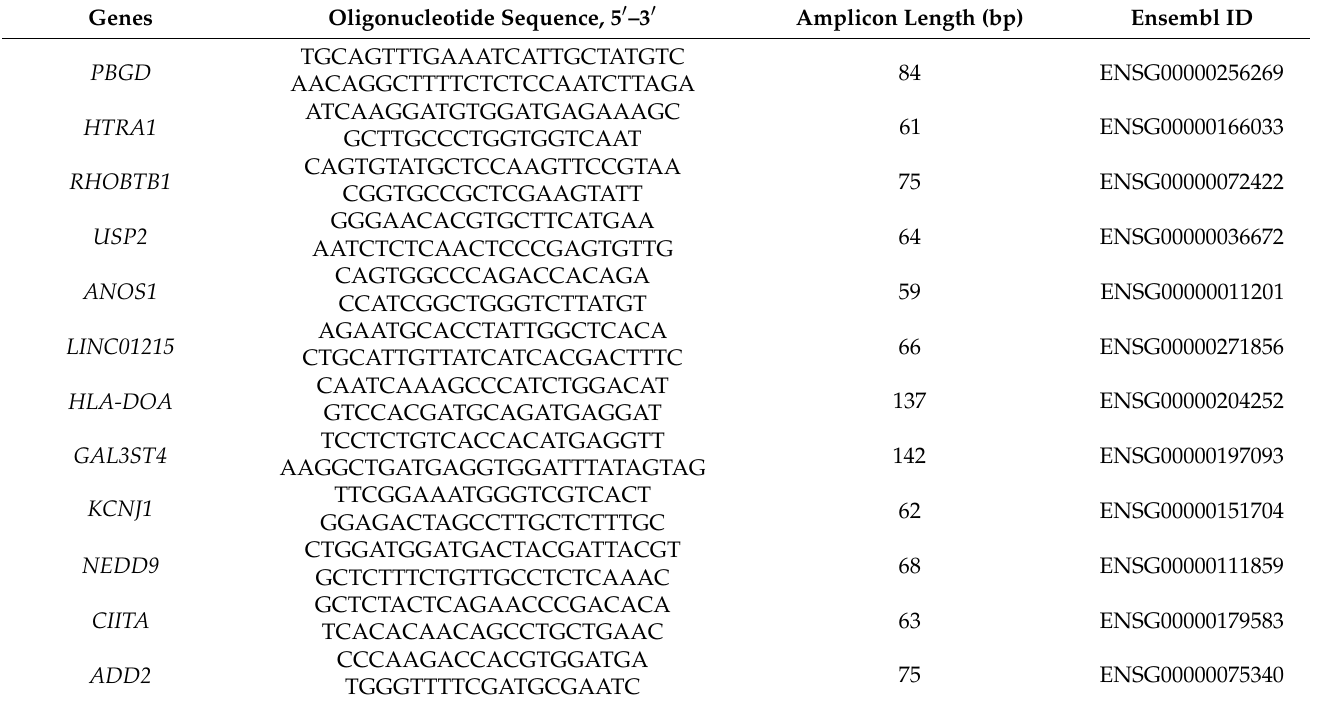
Table 2. Primer sequences used for quantitative